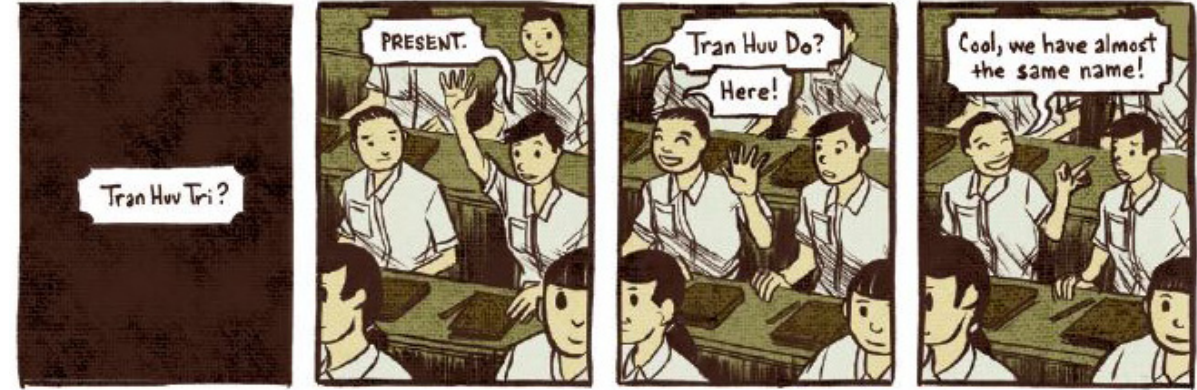
Figure 2: Tran, GB (2011) Vietnamerica (London: Villard, 71: 1–4).